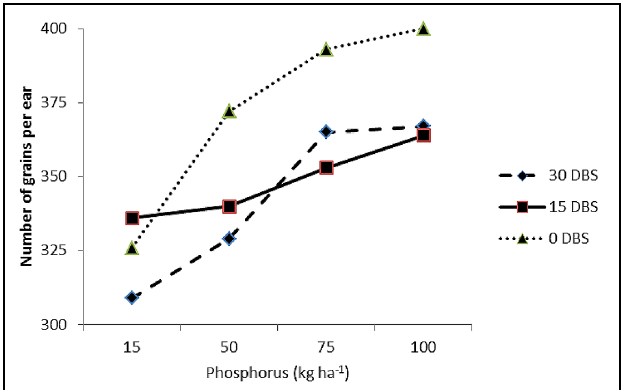
FIGURE 1 | Response of number of grains per ear of maize ( Zea mays L.) to phosphorus levels (P) and compost application time (C) interaction (P ×